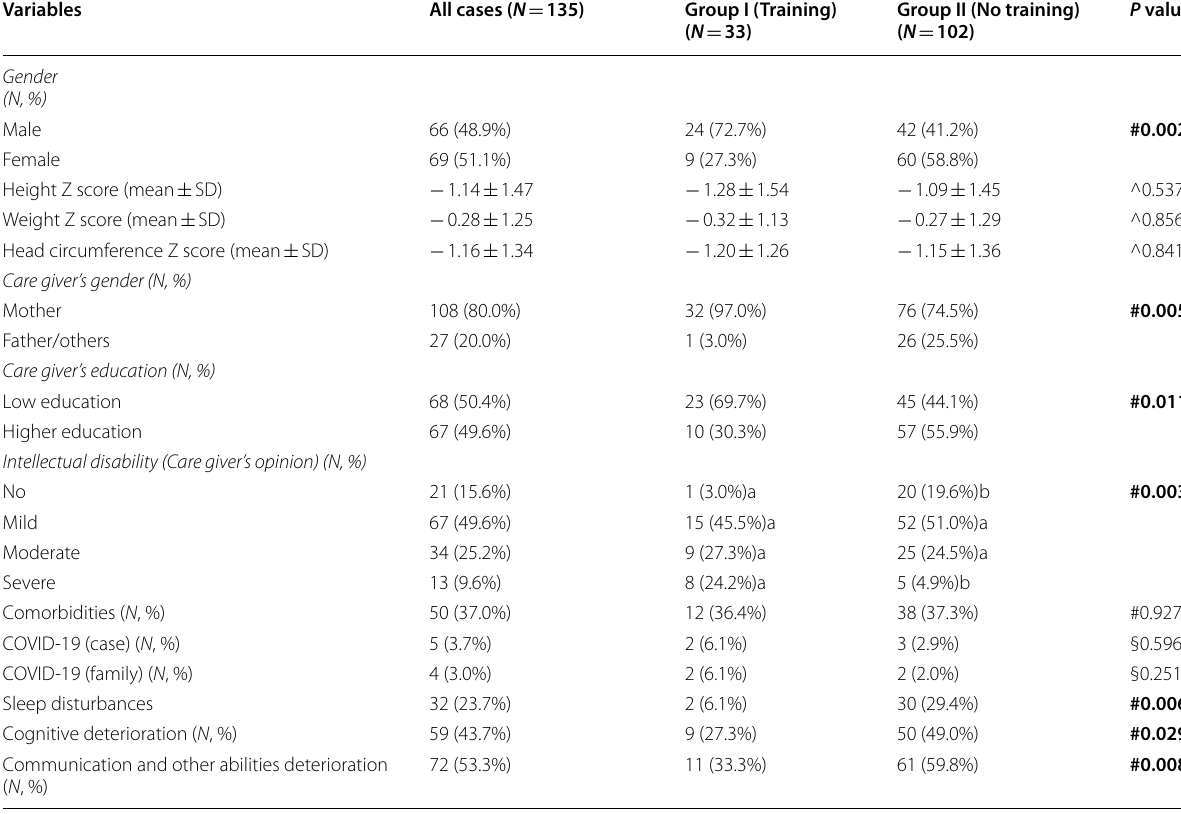
Bold indicates the level of significance was taken at P value <